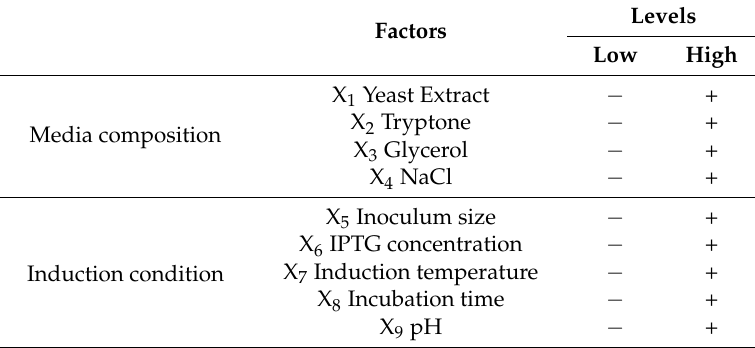
Table 2. An example of a two level experimental design having nine factors that are known to influence recombinant protein expression. In this case the nine factors relate to two experimental components; media composition and induction conditions. When planning the screening phase the selected factors (yeast extract, tryptone, glycerol, NaCl, Inoculum size, IPTG concentration, induction temperature, incubation time and pH, labelled X 1 to X 9 respectively) and associated levels (high, defined as +1 and low defined as − 1 are selected to cover the intended experimental space (i.e., to cover the productive range). The levels are defined as the range between the known working limits. Levels Factors Low High X 1 Yeast Extract − + X 2 Tryptone + Media composition X 3 Glycerol X 4 NaCl X 5 Inoculum Induction condition